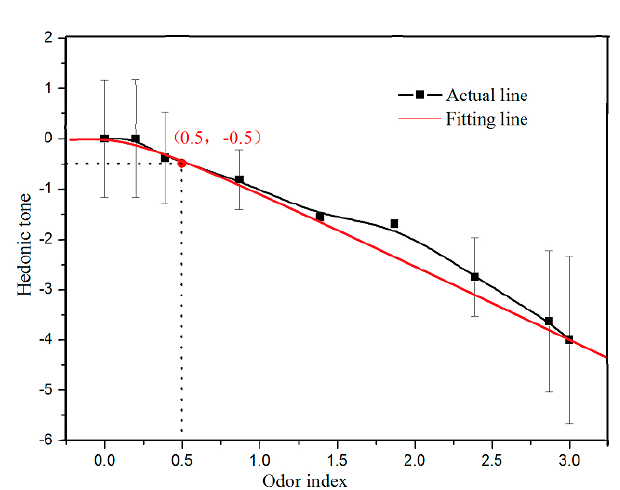
Figure 1. The behavior curve of dimethyl disulfide. The black line is the actual line, the red line is the fitting line and the red point is the hedonic tone of − 0.5.